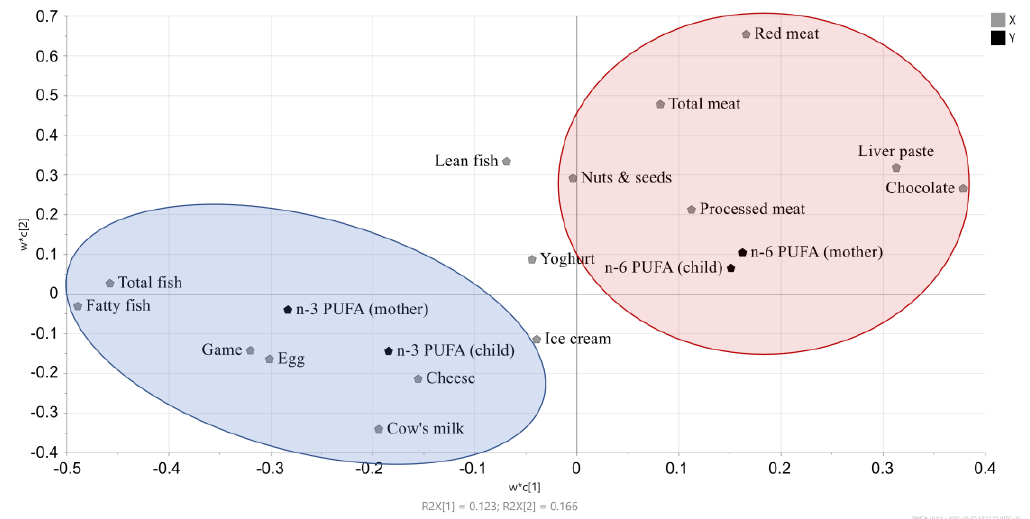
Figure 4. Partial least squares (PLS) loading plot showing the associations between maternal food intake during pregnancy and proportions of n-3 and n-6 polyunsaturated fatty acids (PUFAs) in the infant’s and mother’s plasma phospholipids at birth (N = 196 mothers and N = 196